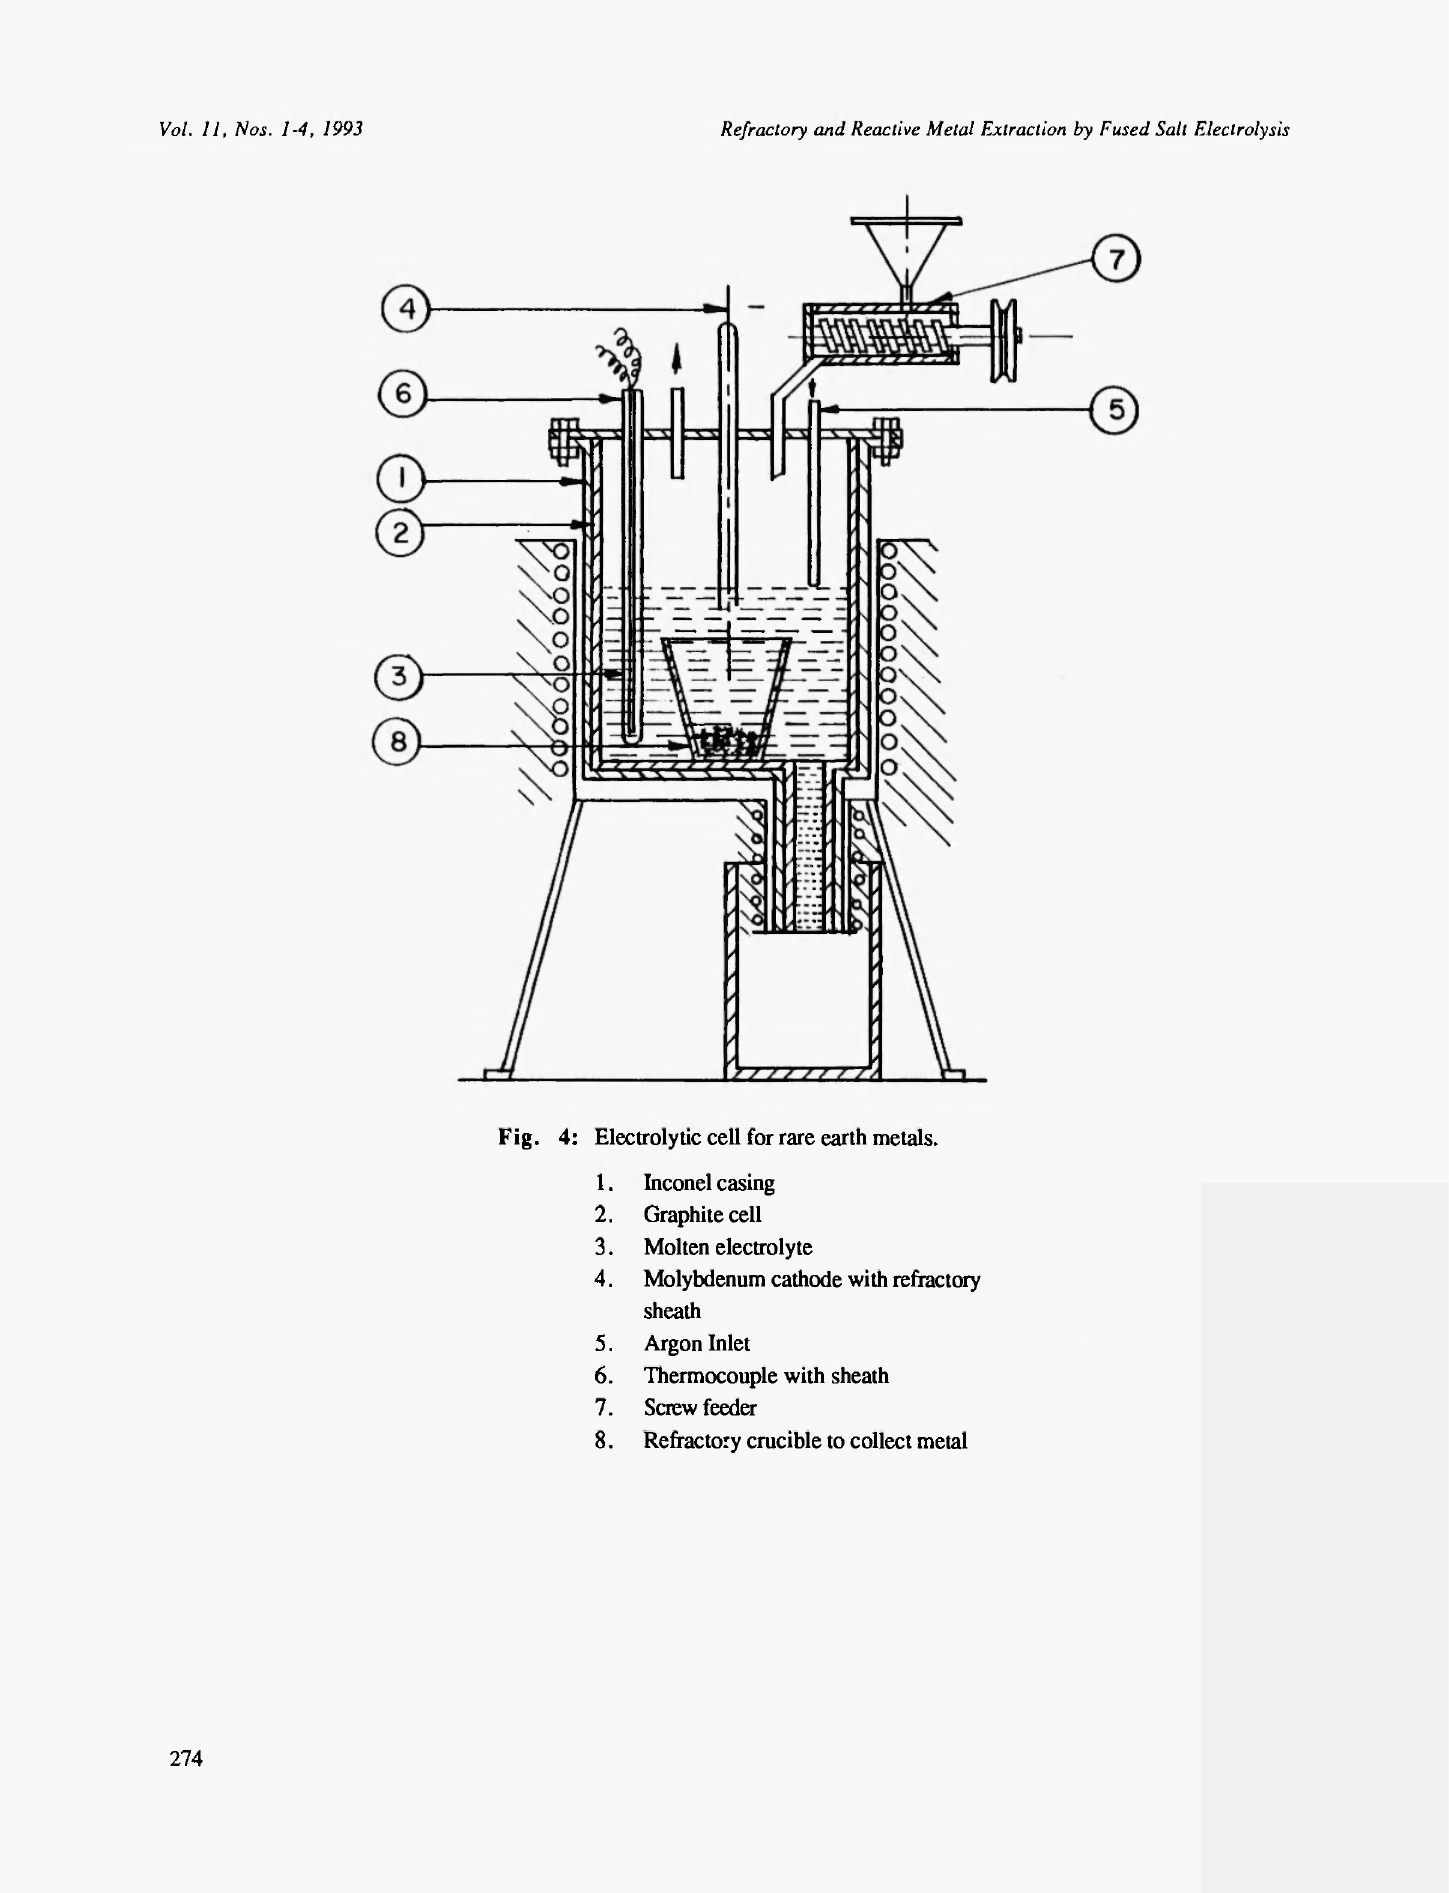
Fig. 4: Electrolytic cell for rare earth